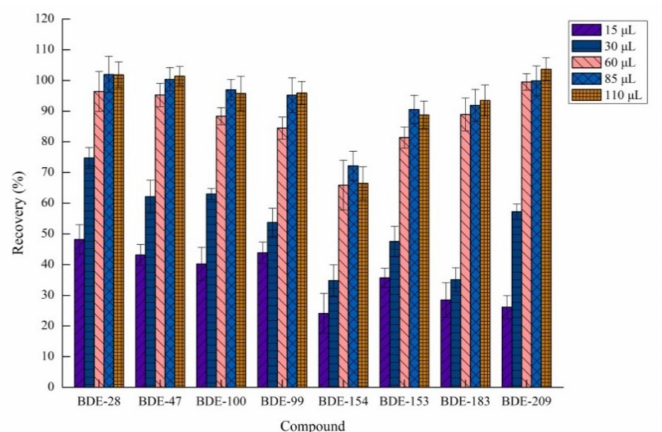
Figure 4. Effect of volume of acetic acid on recovery ( n =